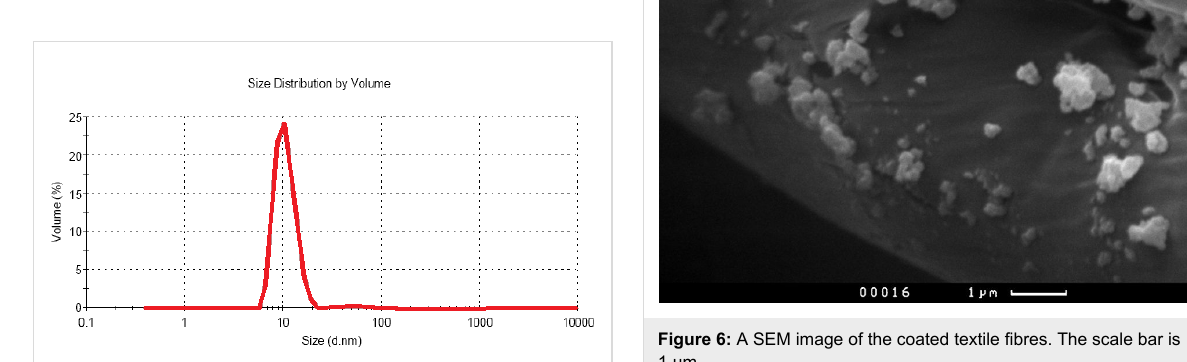
Figure 3: SEM image of ZnO NPs produced in a sonoplasma discharge. The scale bar is 10 nm. We have obtained the size distribution of the zinc oxide parti- cles produced in the sonoplasma discharge by using DLS measurements (Figure 4). The results confirm that a stable monodispersed suspension of ZnO NPs can be produced by using a sonoplasma discharge. A narrow size distribution of particles with an average size of 10 nm is obtained from the DLS measurements, which is in good agreement with the SEM data.